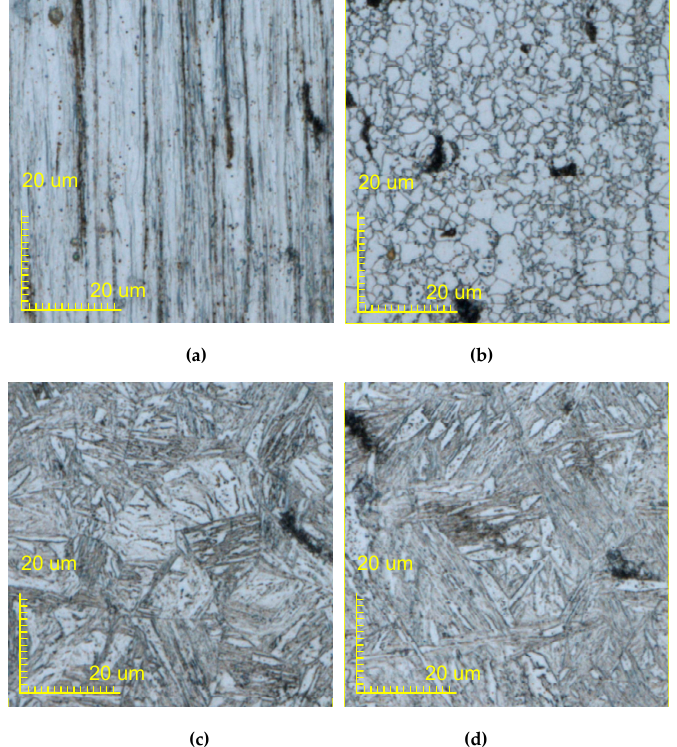
Figure 16. Micrographs of double metal wires after melting and solidification in (a) the oxidation region, (b) the heat-affected zone, (c) the semi-melted region , and (d) the melted region. The solidified structure after continuous melting and secondary contact melting is the same. Due to the different temperature distributions, the lengths of the melting regions are different. Therefore, the secondary contact melting of the melt tends to cause an uneven shape of the manufactured metal parts. By increasing the length of the metal wire, the temperature distribution can be changed, so that the melting length of the metal wire can be increased, and the problem of uneven shape of the part can be improved. 5. Conclusions In this paper, the differences between the continuous melting process of the metal wire and the secondary contact melting process of the metal melt were analyzed. The results can be summarized as follows. (1) The continuous melting and secondary contact melting of metal wire materials are different in the melting process in the solid-state temperature rising stage. There is a contact interface in the second contact of the melt, which can generate heat quickly. The temperature of the metal wire increased rapidly to 1100 °C, and then slowly increased to 1400 °C. When the metal wire is continuously melted, the temperature increases linearly to 1400 °C. (2) The continuous melting and secondary contact melting of metal wire materials have different trends in dynamic resistance during a solid-state temperature rise. There is contact resistance during the second contact melting process. The resistance value decreased linearly to eliminate the contact interface, and then gradually increased the maximum value. During the continuous melting process of the metal wire, the resistance value increases linearly to the maximum value. (3) The temperature distribution of the continuous melting process of the wire and the secondary contact melting process are different. The heat generated during the continuous melting process of the metal wire originates from the overall resistance of the metal wire, and the temperature distribution is "bow-shaped." In the second contact melting, the heat generated by the contact interface resistance is transferred to both ends of the metal wire to melt, and the temperature distribution is "inverted V." (4) According to the temperature distribution and microstructure analysis of the metal wire, the microstructure distribution of the metal wire’s continuous melting and secondary contact melting solidification is the same. The continuous melting length of the metal wire is greater than the melting length of the secondary contact.